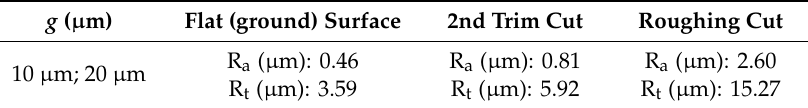
Table 2. Gap width and initial part surface roughness for the experiments.